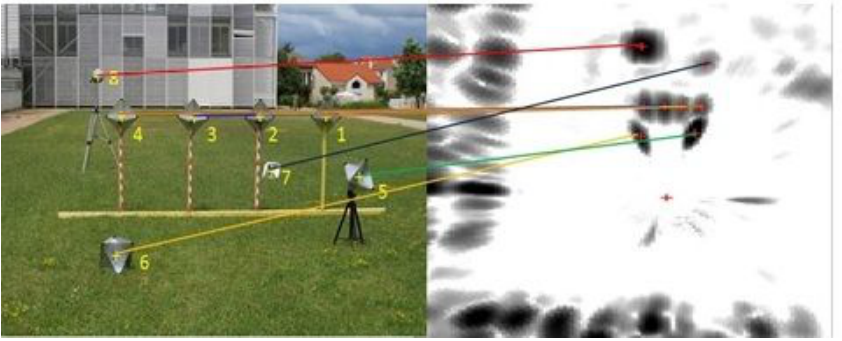
Figure 19. An image and a panoramic of targets. The targets are numbered from 1 to 8: one Luneburg lens and seven trihedral corners. The yellow crosses indicate the centers of the targets. The variations of amplitude of the reflected signal are introduced by the nature and orientation of each target. Manually-extracted matches between the image and the PPI are